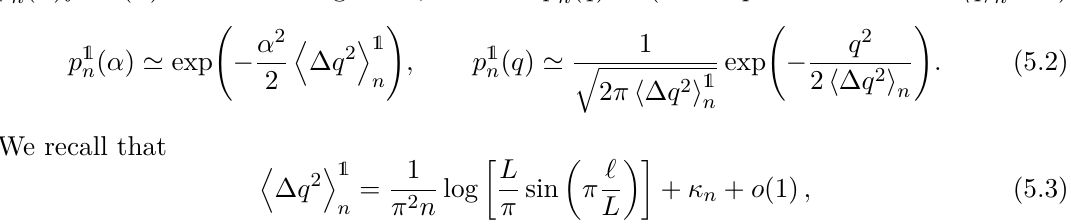
JHEP10(2021)195 (cid:10) ∆ (cid:11) V 1 ,i∂φ (cid:10) ∆ (cid:11) 1 as a q 2 − q 2 (1 , 1) 2 (cid:10) ∆ (cid:11) 1 is plotted for different values of β ( β = 1 , 2 , 3 ) − q 2 (1 , 1) 2